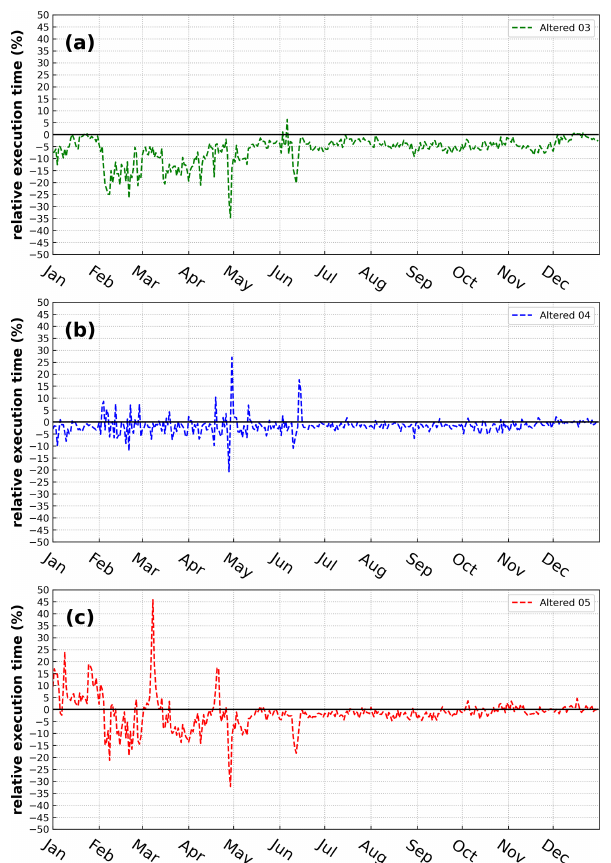
Figure 3. Relative daily runtime with respect to different adjusted emission input for the A03, A04, and A05 simulations for